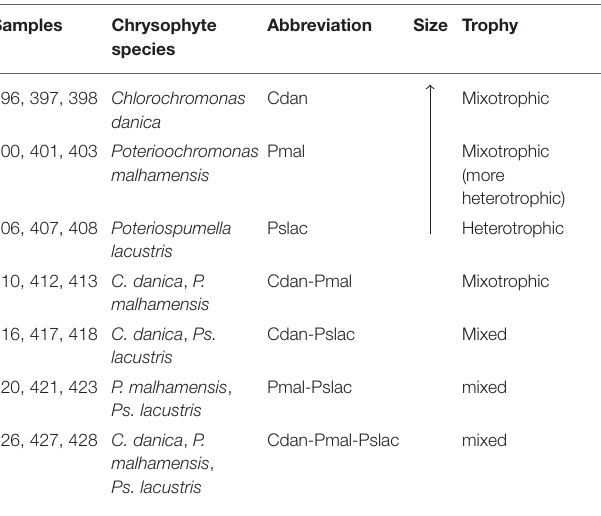
TABLE 1 | Experimental design. Overview of conditions and combinations of chrysophyte species which were grown with Polynucleobacter asymbioticus .